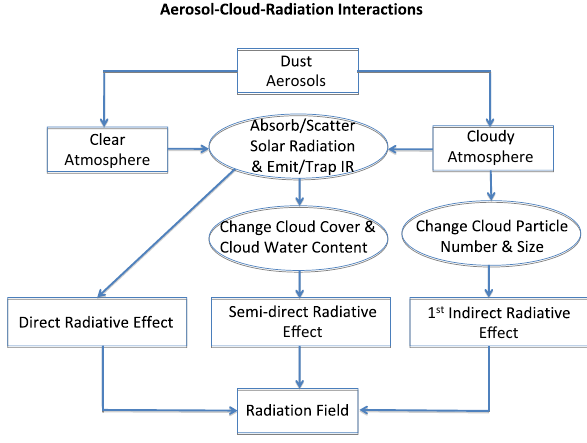
Fig. 1. Flow chart of aerosol-cloud-radiation